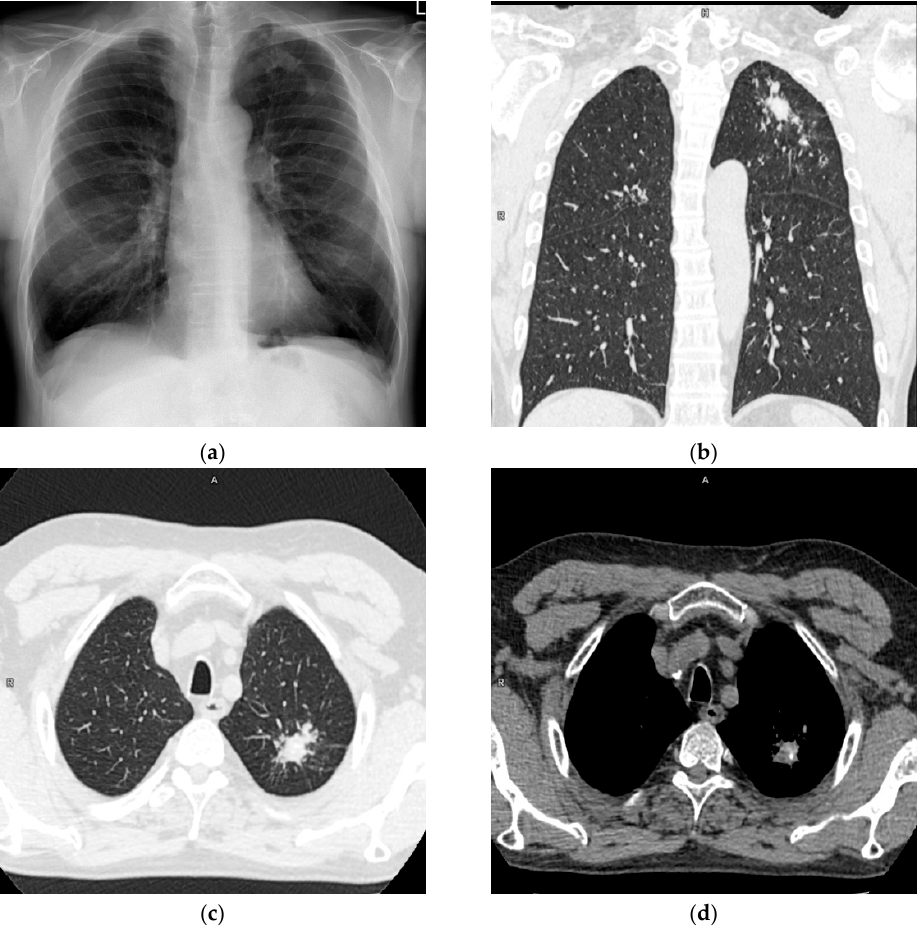
Figure 1. Chest X ‐ ray and CT ( a ). Chest X ‐ ray, posteroanterior projection. Irregular shape consolidation in the upper zone of the left lung. ( b ). Chest CT, lung window, coronal image. Various shape and size lung nodules in the left upper lobe. ( c ) Chest CT, lung window, axial image. The largest lung nodule with spiculated borders is in the left upper lobe. ( d ) Chest CT, mediastinal window, axial image. Calcifications in lung nodules.